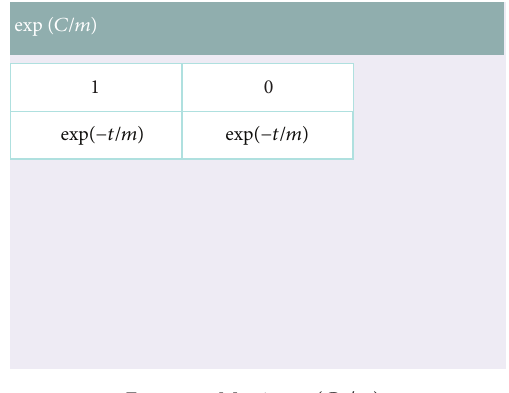
Figure 7: Matrix exp (𝐶𝑡/𝑚) .